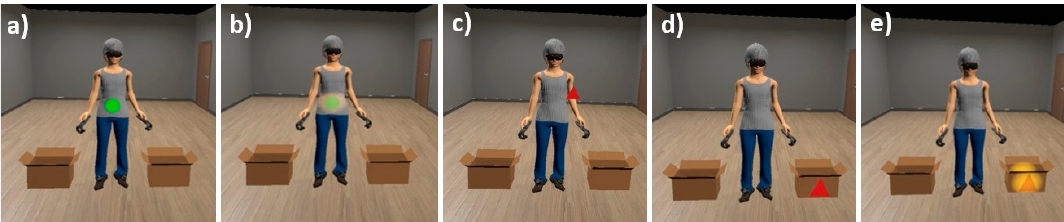
Figure 4. ABMT trials. From left to right: figures appearing on the weight-related body part (stomach): ( a ) initially and ( b ) with illumination on the near-body (while the participant looked at the figure); ( c ) on the non-weight-related body part initially (arm); on the neutral stimulus (box): ( d ) initially and ( e ) with illumination on the area near to the box (while the participant looked at the figure).